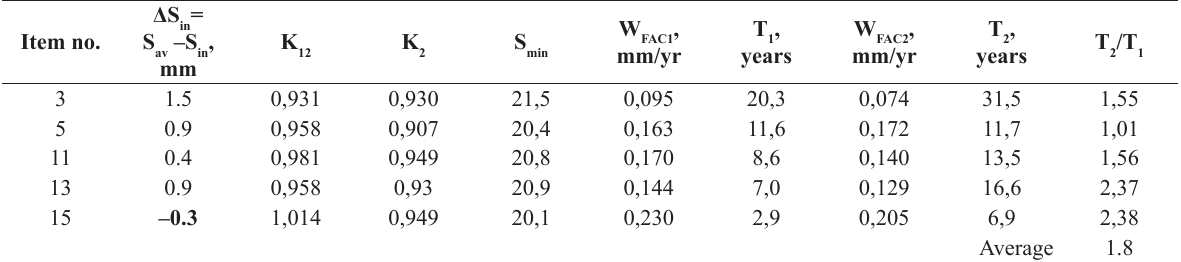
Table 5. Values characterizing residual lifetime of WZ inlet of pressure pipelines of feed electric pump and emergency feed pumps. Item no.